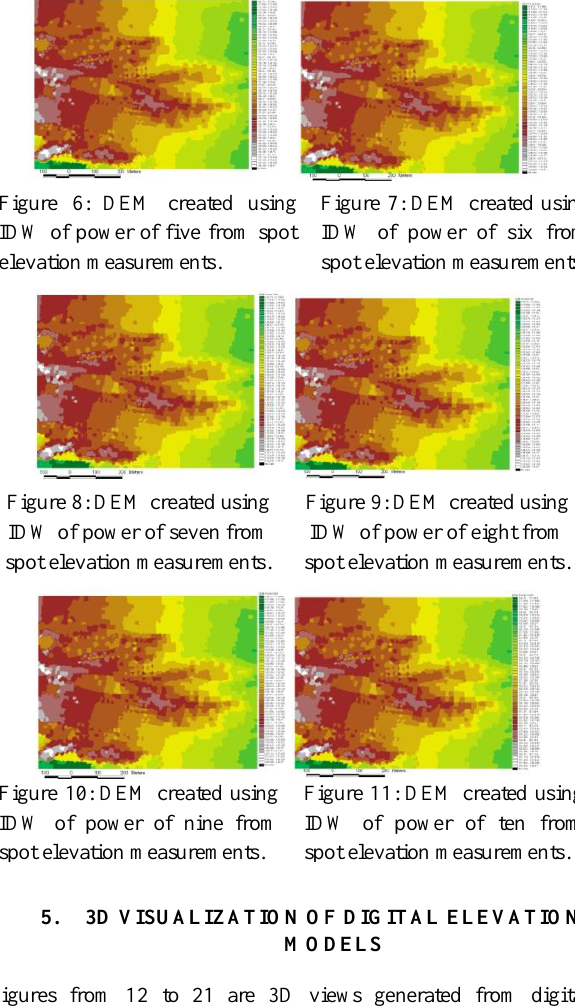
Figure 2: DEM created using IDW of power of one from spot elevation measurements.